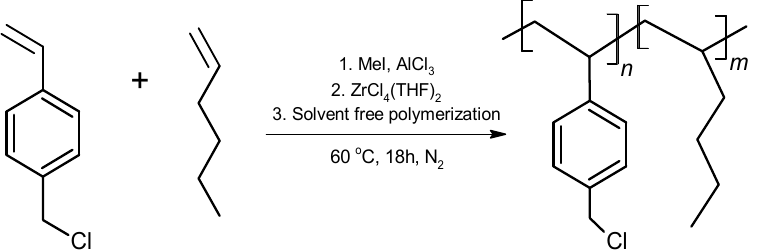
Figure 1. Ziegler–Natta polymerization for the synthesis of poly(VBCl-co-hexene). One of the most accepted mechanisms for the Ziegler–Natta polymerization reaction was established by Cossee in 1964. The activation of the catalyst is reported in Figure 2a [45].